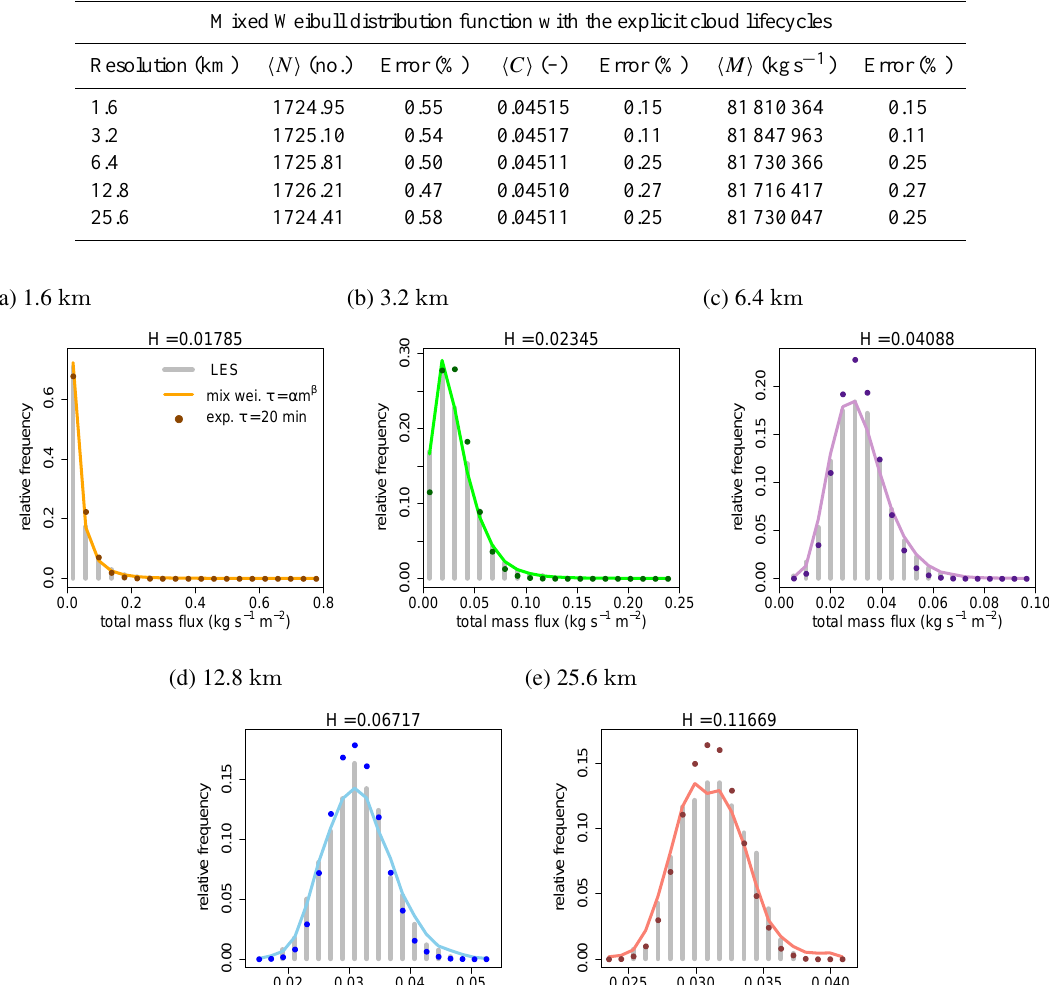
where p i and q i are the corresponding probability